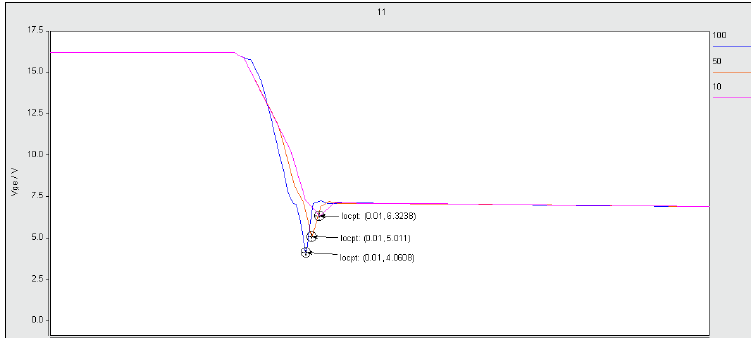
Figure 8. V ge comparison diagram under different R 4 values.